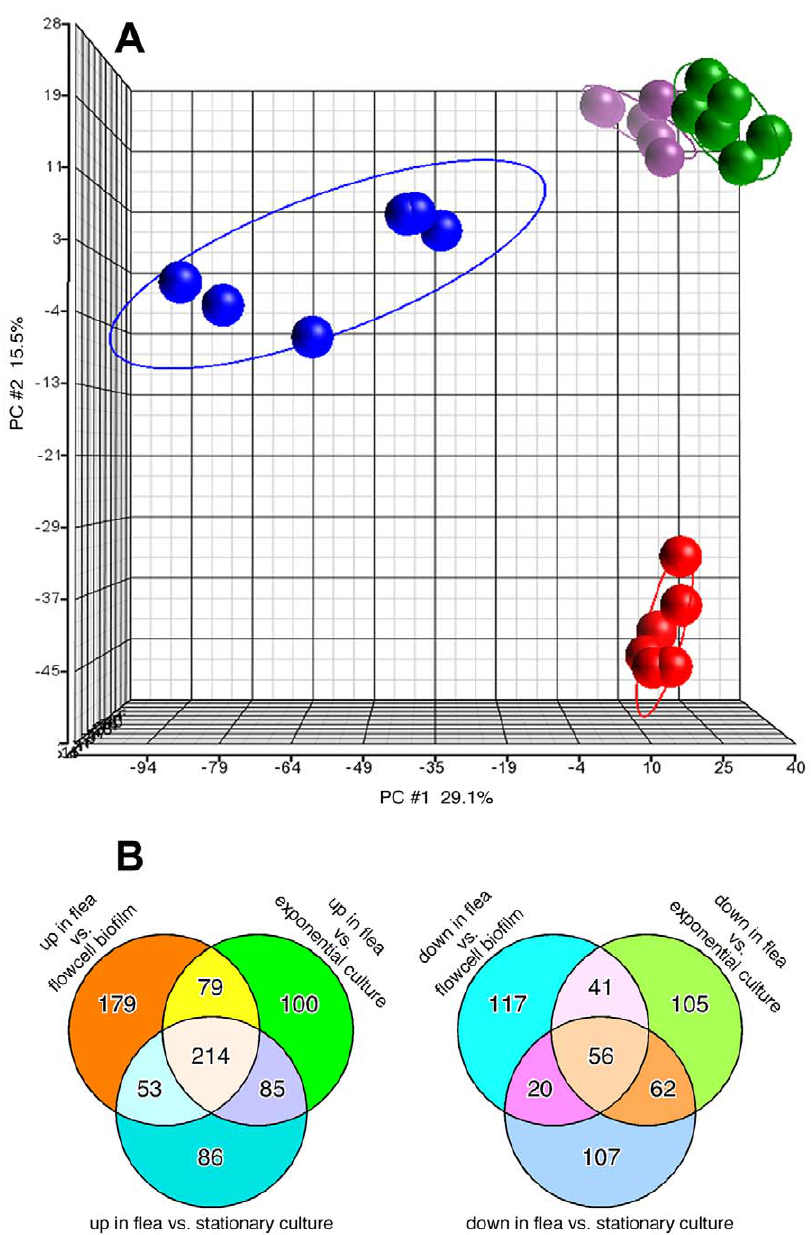
Figure 1. Distinct transcriptional profile of Y.pestis in infected fleas. (A) Principal Component Analysis (PCA) representation of replicate microarray gene expression profiles of Y. pestis KIM6 + from blocked fleas (blue symbols) and from in vitro flowcells, exponential phase planktonic cultures, and stationary phase planktonic cultures (red, green, and purple symbols, respectively). (B) Venn diagrams representing the number of Y. pestis genes upregulated or downregulated $ 2-fold in the flea relative to in vitro culture